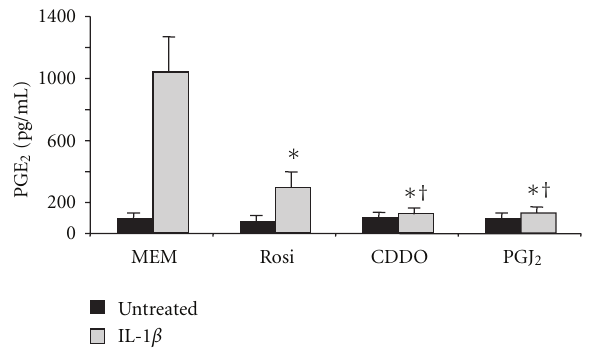
Figure 5: PPAR γ ligands attenuate IL-1 β -induced PGE 2 production in human lung fibroblasts. Primary human lung fibroblasts were pretreated with 20 μ M rosiglitazone (Rosi), 1 μ M CDDO, or 5 μ M 15d-PGJ 2 (PGJ 2 ) and then cotreated with IL-1 β for 24 hours as previously described. Supernatants were harvested, and PGE 2 was determined by EIA. PGE 2 production is significantly reduced in PPAR γ ligand-treated fibroblasts compared to IL-1 β alone ( ∗ P < . 001). CDDO and 15d-PGJ 2 were significantly more potent than rosiglitazone ( † P < . 05). Results are mean ± standard deviation for quadruplicate wells and are representative of 3 independent experiments that yielded similar results. Data were analyzed by